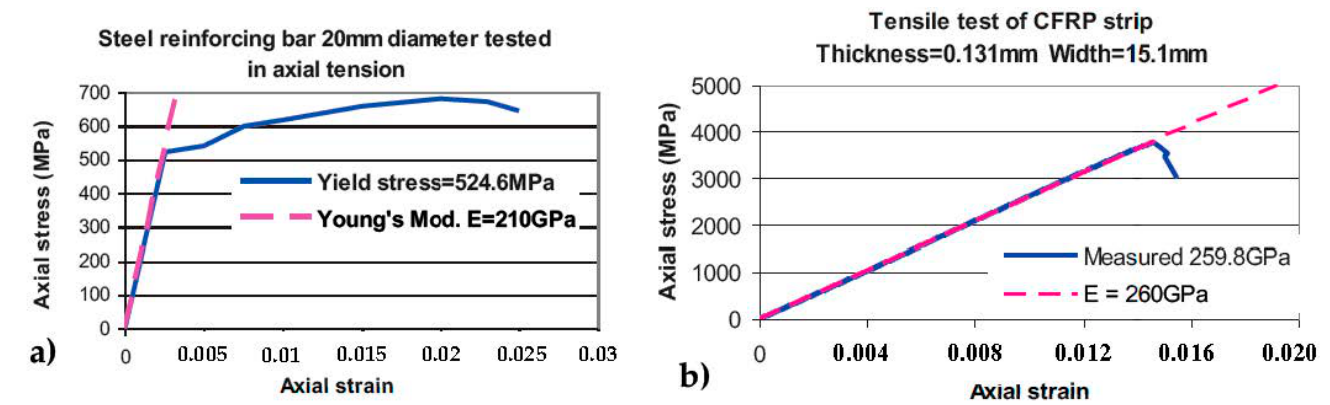
Figure 6. ( a ) Typical tensile test results of longitudinal reinforcement. ( b ) Typical tensile test results of CFRP strip.